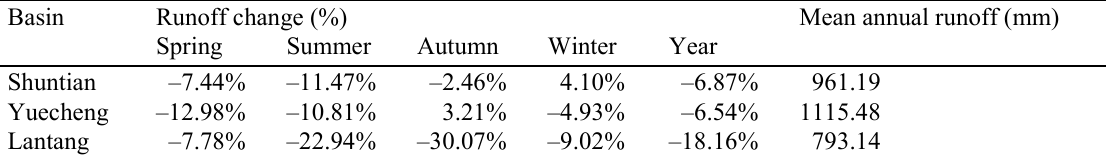
Table 3 The percentage of change of runoff compared to baseline period.